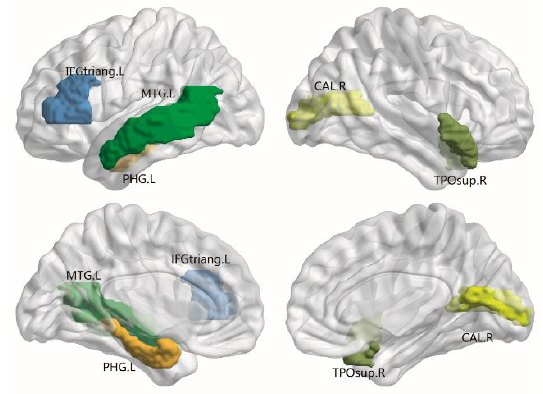
Figure 2. The distribution of brain regions with significant differences in nodal efficiency in FN- weighted white matter networks between the ALA and HC groups. IFGtriang.L: left triangular part of inferior frontal gyrus; MTG.L: left middle temporal gyrus; PHG.L: left parahippocampal gyrus; CAL.R: right calcarine fissure and surrounding cortex; TPOsup.R: right temporal pole of superior temporal gyrus.